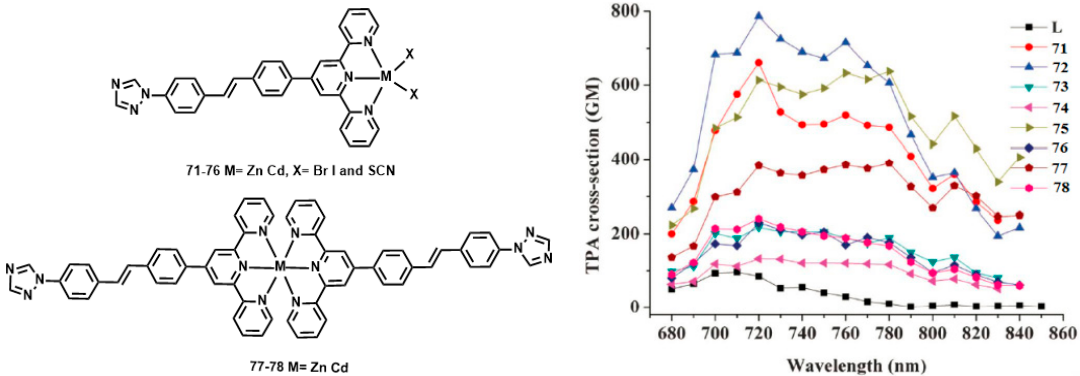
Figure 18. The structures of 71 – 78 and two-photon absorption cross-sections of L and its complexes 71 – 78 in DMF.